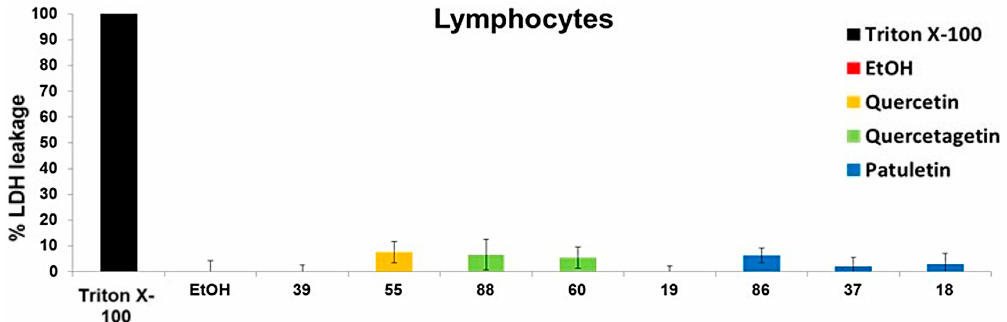
Figure 13. Evaluation of necrosis by quercetin, quercetagetin and patuletin on normal cell lymphocytes. The medium was removed, and the cells were stimulated to the level of IC 50 values for quercetin, quercetagetin and patuletin, as well as with EtOH (10 µ L/mL). After 24 h, the amount of lactate dehydrogenase (LDH) released from the culture supernatant was evaluated. Experimental data are presented as mean ± S.D. for three independent experiments with three repetitions.